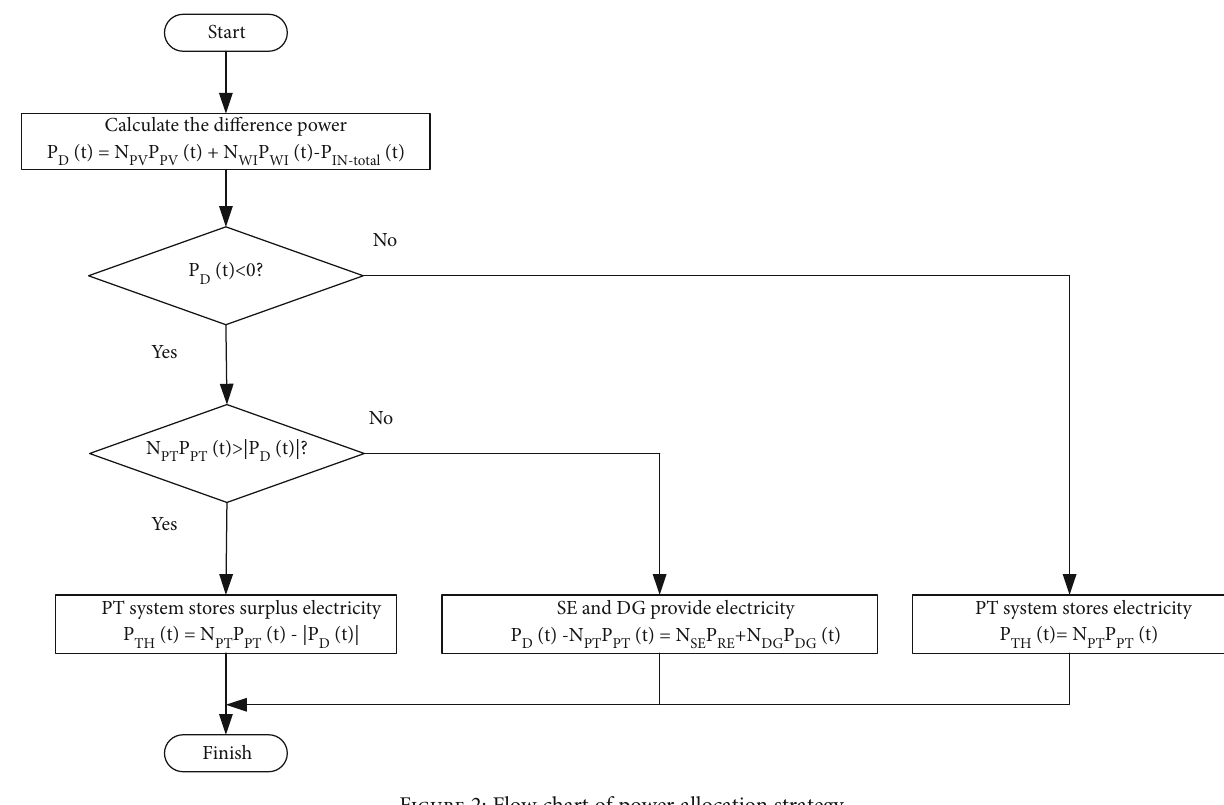
Figure 2: Flow chart of power allocation strategy.